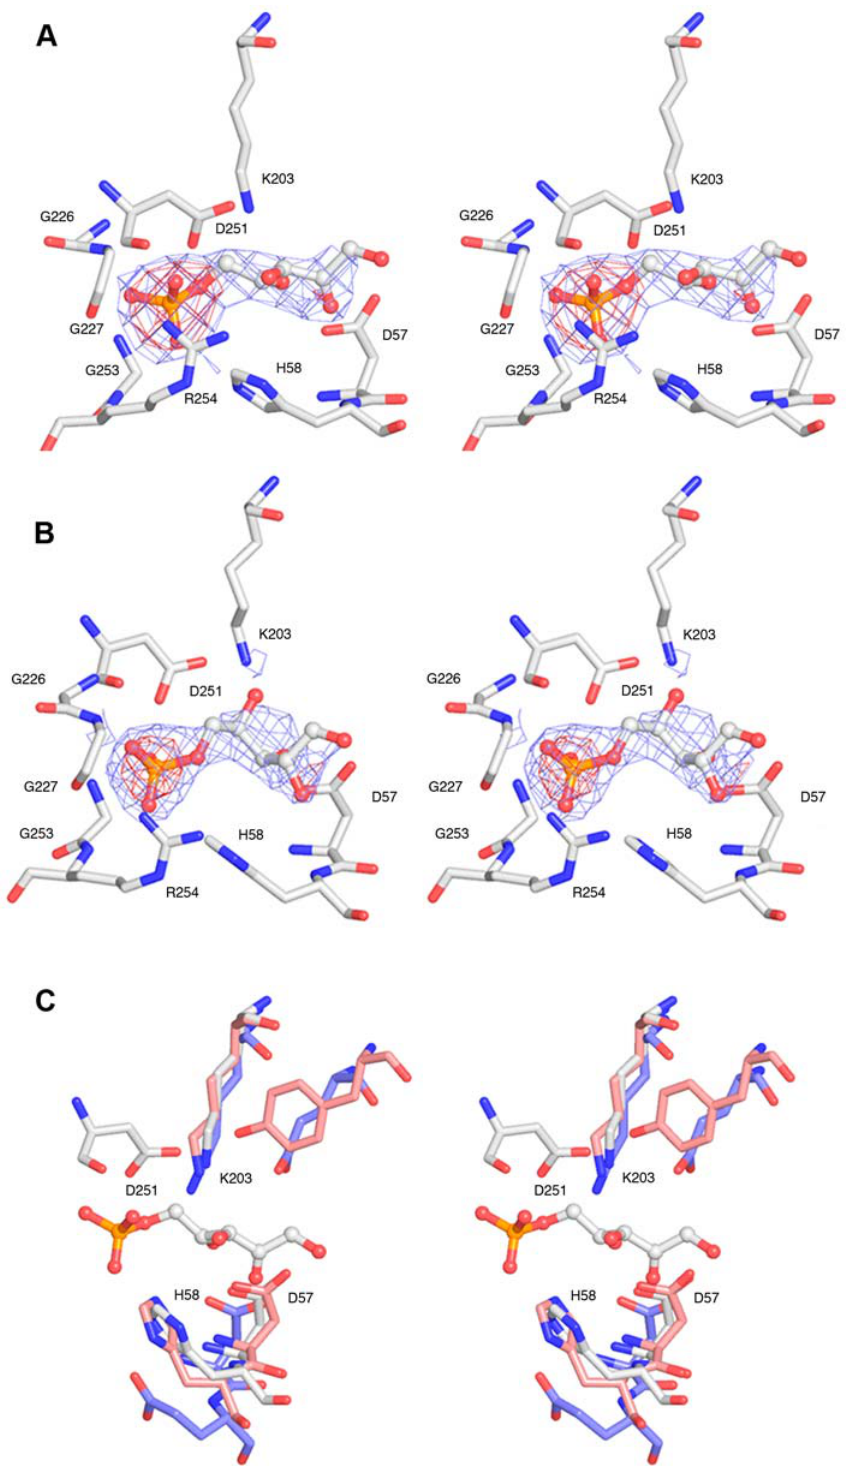
Figure 5. The LsrF ligand binding site and potential catalytic residues. A. Stereoview of ribulose-5-phosphate bound to LsrF showing 20-fold NCS averaged 2F 0 -F C electron density. Density was contoured at 4.0 (red) and 2.0 (blue) s and truncated 2.0 A˚ from ligand atoms. The position of the phosphate is unambiguous, and the general path of the ligand is clear. B. Stereoview of ribose-5-phosphate bound to LsrF showing 20-fold NCS averaged 2F 0 -F C electron density. Density was contoured at 5.0 (red) and 2.0 (blue) s and truncated 2.0 A˚ from the ligand. The position of the phosphate is unambiguous, and the general path of the ligand is clear. C. Structural alignment of key catalytic residues from rabbit (blue bonds; 1J4E) and T. tenax (red bonds; 1OK4) FBPA with LsrF (white bonds). Ribulose-5-phosphate from LsrF is shown in ball and stick form. Residue numbering follows LsrF.